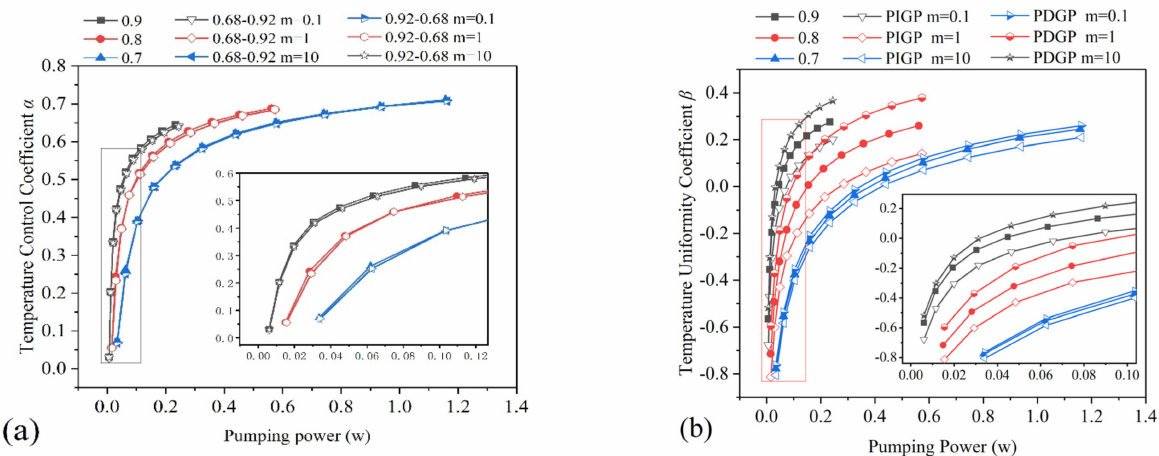
Figure 18. ( a ) Temperature control coefficient α , ( b ) temperature uniformity coefficient β (with AFHS with gradient porosity designed in the X -axis